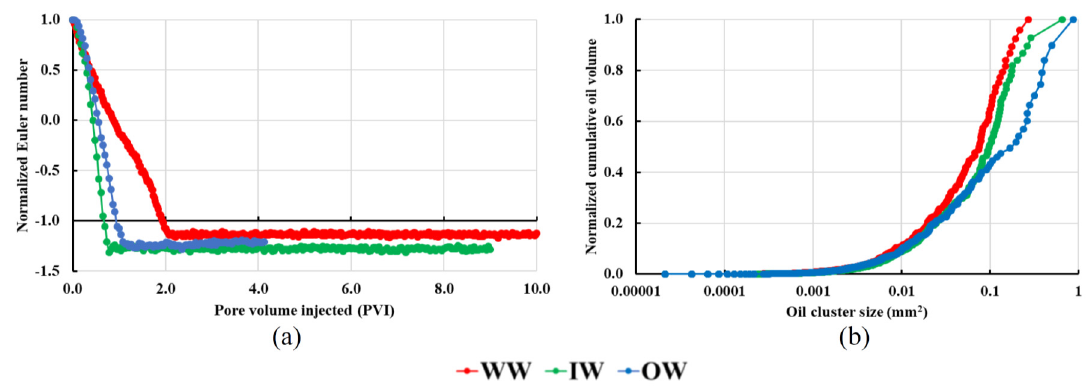
Figure 7. Ultimate oil recovery and corresponding injected pore volume (PVI) for SSW and PSiNP flooding at 0.1 µL/min.